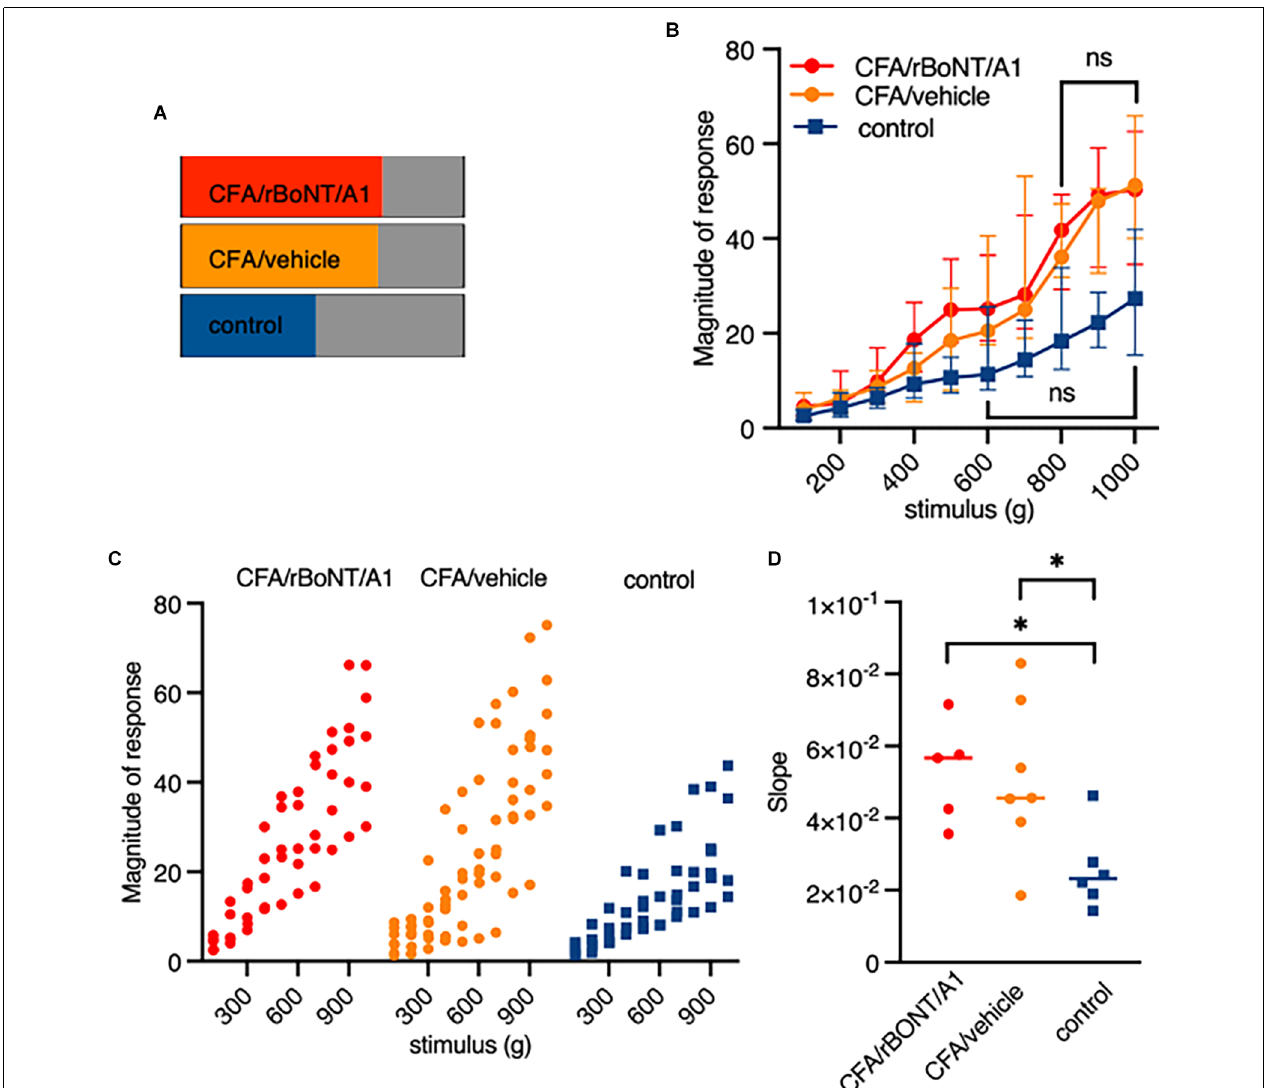
FIGURE 5 | Pressure responsive “noiceptors” are sensitized by inflammation but not inhibited by rBoNT/A1 on a cellular level. (A) Percentage of identified “nociceptors” under indicated conditions. (B) Magnitude of responses over stimulus in the three different treatment groups as median plus interquartile range. Significant difference between 100 and 700 g in CFA/rBoNT/A1 and CFA/vehicle as well as 100–500 g in control (PBS) group compared to maximum stimulus. Indication in graph highlights first stimulus that is not significantly different to 1,000 g. No difference in between the CFA/rBoNT/A1 and CFA/GPB treatment groups. Mixed-effect analysis, post hoc Tukey. p < 0.05. (C) Magnitude of responses in individual animals presented as data clouds over stimulus grouped by treatment. (D) Comparison of response/stimulus slopes from individual mice calculated from the median in Figure 4B . Welch ANOVA, post hoc Dunnett. ∗ p < 0.05. n (CFA/rBoNT/A1) = 5; n (CFA/vehicle) = 7; n (PBS) = 6. ns, not